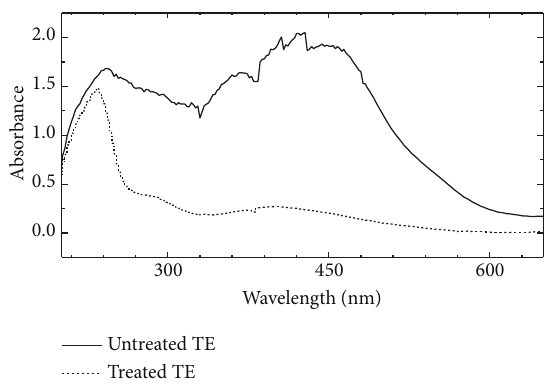
Figure 4: UV-visible spectra of 10% textile effluent before and after treatment of